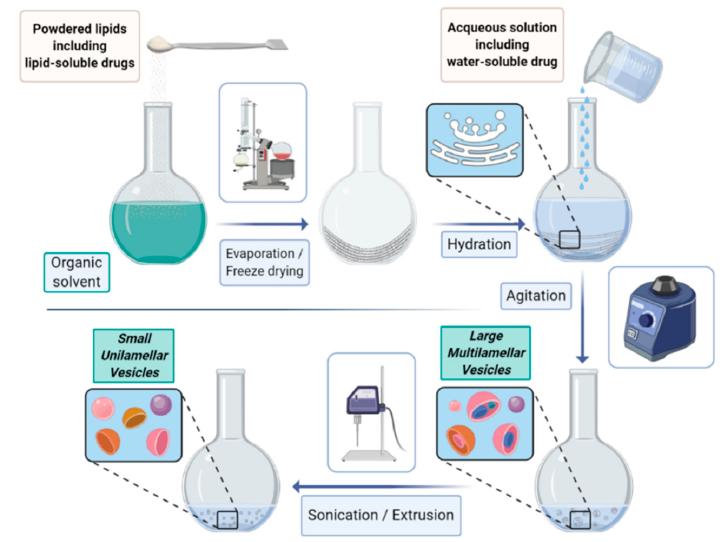
Figure 1. Laboratory procedure for liposome formation. A lipidic film is formed after dehydration in a rotary evaporator, and subsequently rehydrated with an aqueous solvent. The formed vesicles present different sizes and lamellarity, and are then further treated by sonication or extrusion procedures to achieve the desired liposome characteristics.